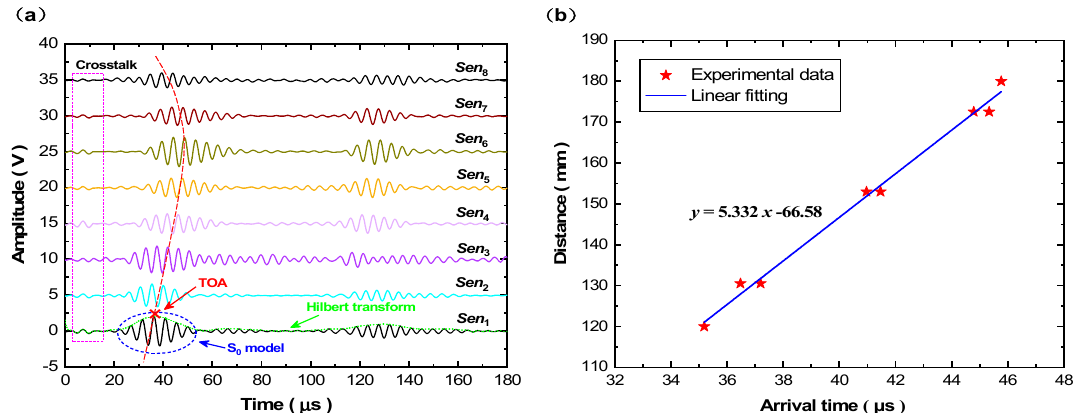
Figure 8. ( a ) GUW signals acquired via all the sensing paths without damage; ( b ) group velocity of S 0 mode calibrated by linear fitting.